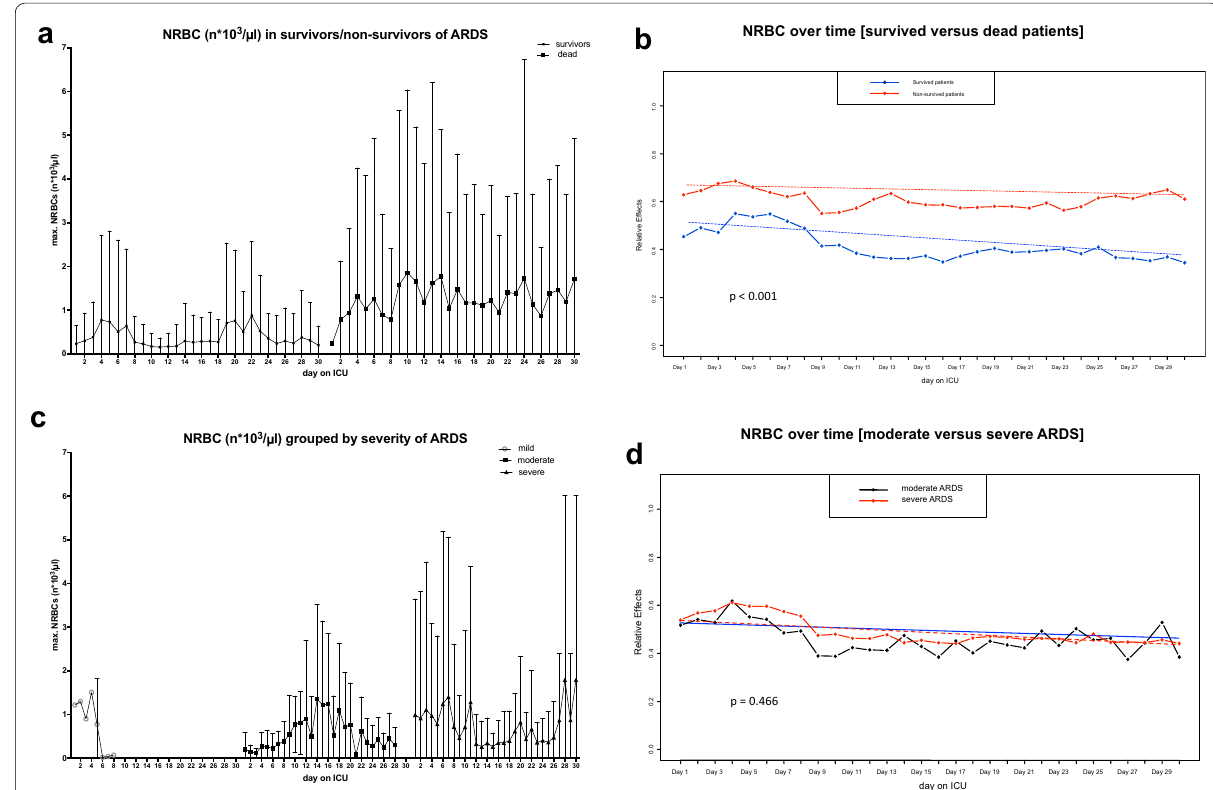
Fig. 2 a Concentration of NRBCs in the blood of ARDS patients on the first consecutive 30 days on the ICU grouped by survivors and non‑survivors. Data are presented as mean standard deviation (SD); n 404. b Development of NRBC counts over the course of time in survivors (blue solid line; ± = blue dashed line indicates trend) and non‑survivors of ARDS (red solid line; red dashed line indicates trend) depicted as relative effect over time. The relative effect presents (in a scale between 0 and 1, and according to a probability) the specific treatment effect of the regarded group, relative to all groups, therefore to a “mean” treatment effect. Multivariate nonparametric analysis for longitudinal data, p < 0.001 for comparison between the two indicated groups. c Concentration of NRBCs in the blood of ARDS patients on the first consecutive 30 days on the ICU grouped by severity of lung failure according to the Berlin definition of ARDS (mild, moderate, severe). Data are presented as mean standard deviation (SD); n 404. d Devel‑ ± = opment of NRBC counts over the course of time in severe ARDS (red solid line; red dashed line indicates trend) and moderate ARDS (black solid line; black dashed line indicates trend) depicted as relative effect over time. The relative effect presents (in a scale between 0 and 1, and according to a probability) the specific treatment effect of the regarded group, relative to all groups, therefore to a “mean” treatment effect. Multivariate nonpara‑ metric analysis for longitudinal data, p 0.466 for comparison between the two indicated groups. The number of patients with mild ARDS was too = low for statistical analysis over time; therefore mild ARDS has been